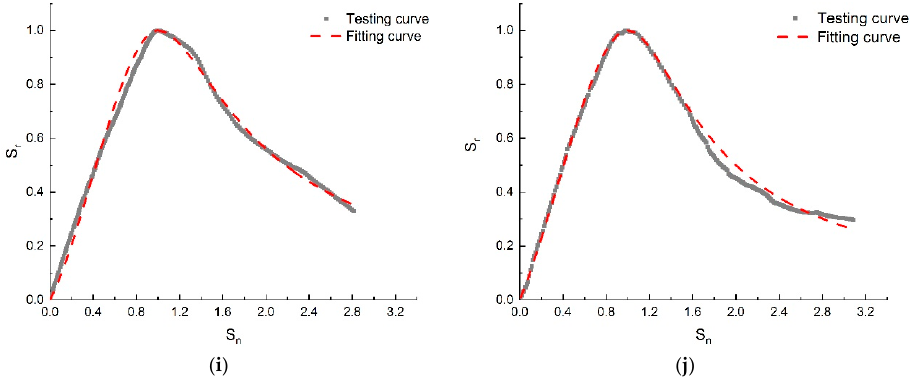
Figure 15. Comparison between the testing and fitting curves of specimens under different conditions. ( a ) 20 ◦ C-RH95%, ( b ) 40 ◦ C-RH25%, ( c ) 40 ◦ C-RH55%, ( d ) 40 ◦ C-RH95%, ( e ) 60 ◦ C-RH25%, ( f ) 60 ◦ Table 6. Data collection of models and parameter estimate under di ff erent conditions. Curing